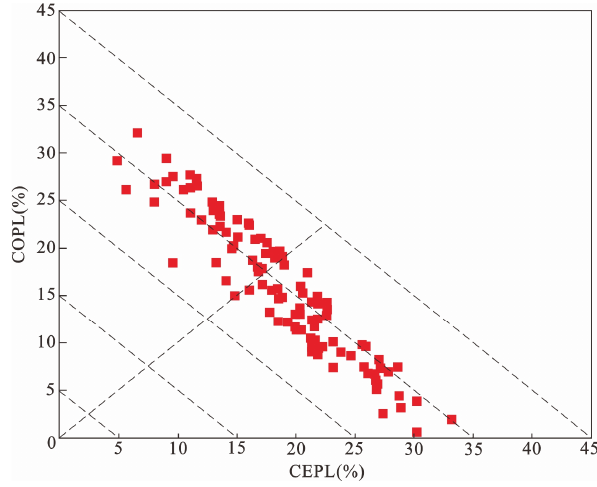
Figure 12. Cross-plot of COPL vs. CEPL [50].